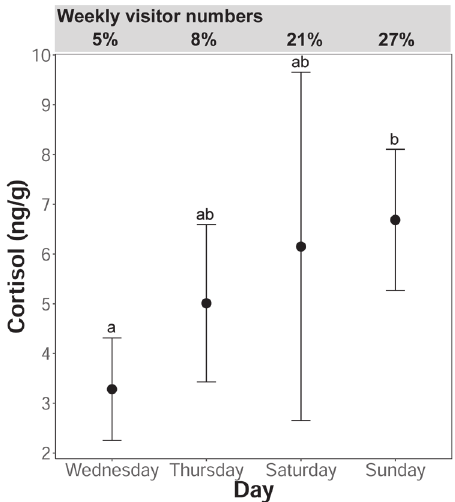
Figure 8. Mean faecal cortisol concentrations and 95% confidence interval from samples collected at different days of the week. Different letters indicate significant differences at p=0.05. The grey box above the figure shows the weekly percentage (of the total) visitor numbers during the period when the samples were collected. Data collected from Lyme Park, Disley, UK, in